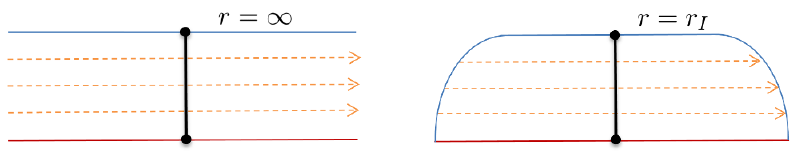
Figure 2 . The AdS 2 slices in the hyperbolic black hole. The red line is the null modular (cid:13)ow line of the black point on ~ E ~ on the horizon. The orange dashed arrow are the modular (cid:13)ows along the A ~ (cid:28) direction. On the left (cid:12)gure the blue line maps to the modular (cid:13)ow line at r = 1 , while on the right (cid:12)gure the blue line maps to the modular (cid:13)ow line pushed to r = r I . Note that, this line is not a modular (cid:13)ow line unless we take the limit r I ! 1